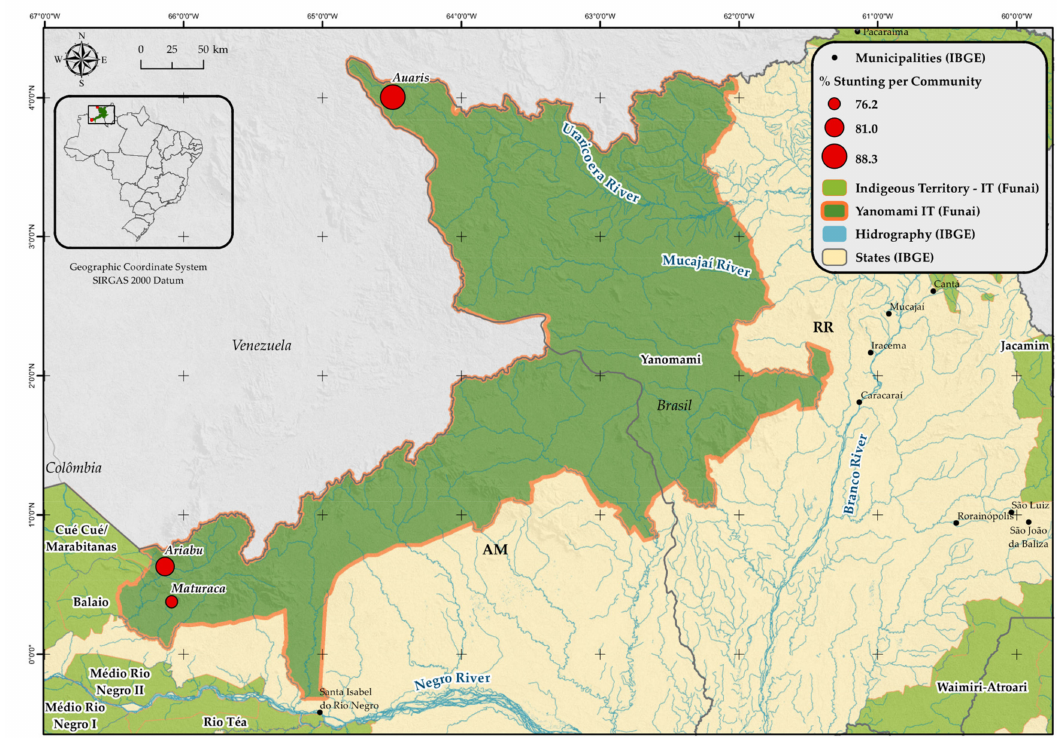
Figure 1. Studied villages in the Yanomami Indigenous Territory (YIT), according to the prevalence of stunting. Roraima and Amazonas states, Brazilian Amazon,